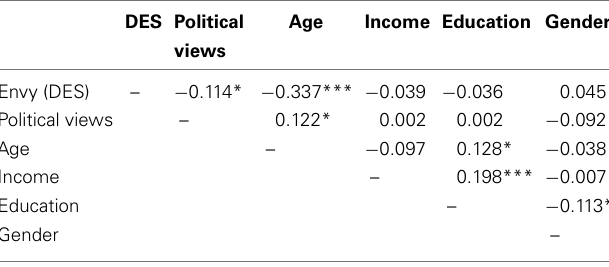
Table 2 | Intercorrelations of dispositional envy, political views, and demographic variables.